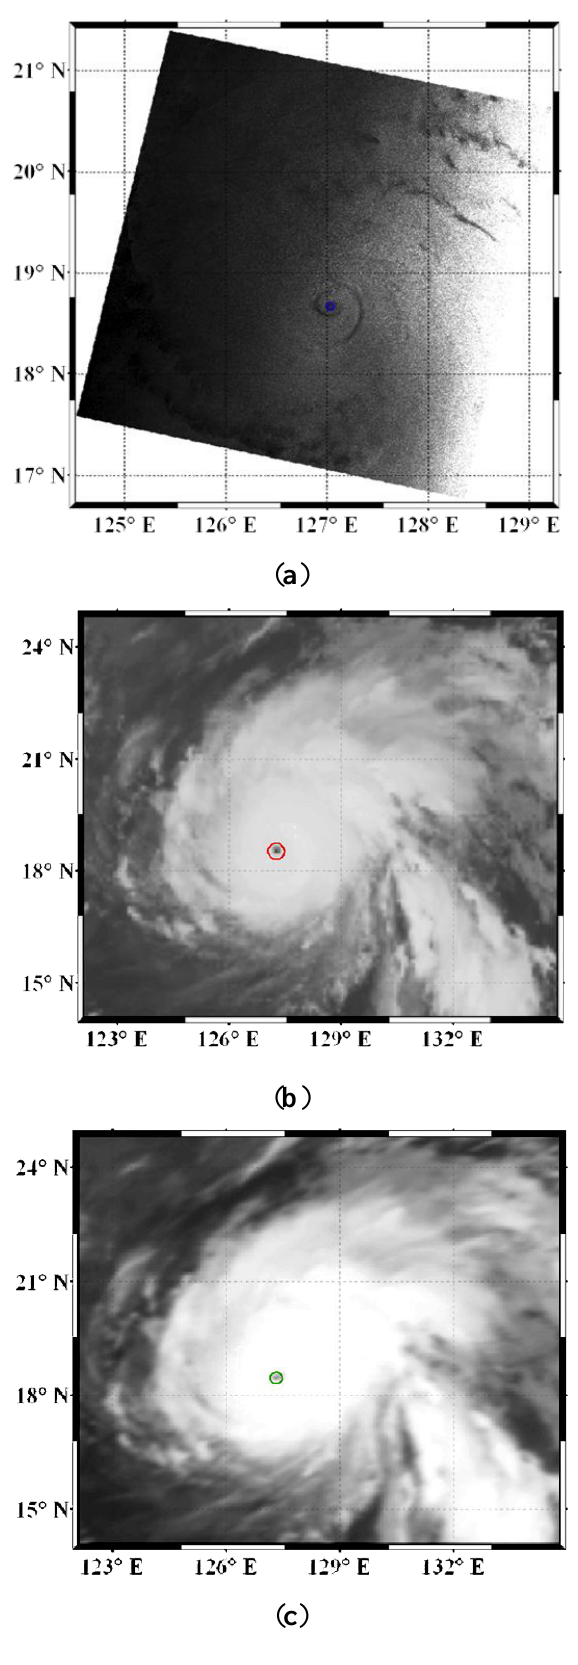
Figure 3. ( a ) Envisat-1 SAR image; ( b ) MTSAT and ( c ) FY-2 IR images of typhoon Megi on 17 October 2010 with the eye boundaries delineated using wavelet